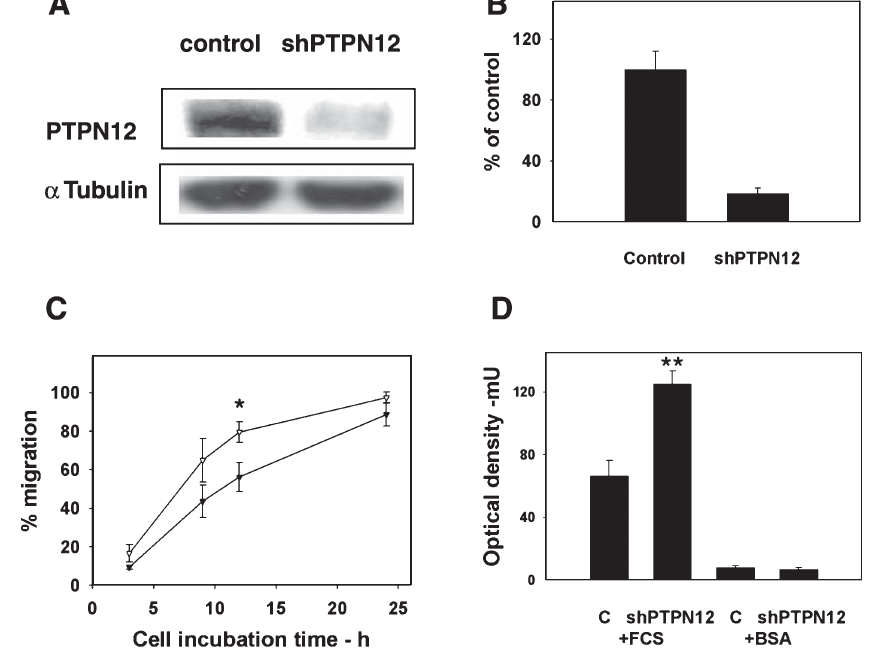
Fig. 3. PTPN12 silencing and effects on cell migration in SKOV-3 cells. (A) PTPN12 protein change. Extracts were prepared from cells carrying stablePTPN12silencingandfromcontrolcells(carryingtheemptyvector)andusedtoimmunodetectPTPN12and (cid:2) -tubulin.(B)Quantification of PTPN12 protein change. PTPN12 protein bands as in A were quantified by densitometric scanning and normalized to (cid:2) -tubulin. Results are given as percent of normalized bands from control cells. Average ± SEM of 3 independent experiments, using 2 different silenced clones. (C) Wound-healing migration assay. Confluent cells were induced to migrate and analyzed as in Fig. 1. PTPN12-silenced (open symbols) and control (filled symbols) cells. Average of 3 experiments ± SEM. Statistical analysis (Student’s t test): ∗ p <0.05. (D) Trans-well migration assay. The assay was performed as in Fig. 1. Average of 3 experiments ± SEM. Statistical analysis (Student’s t test): ∗∗ p